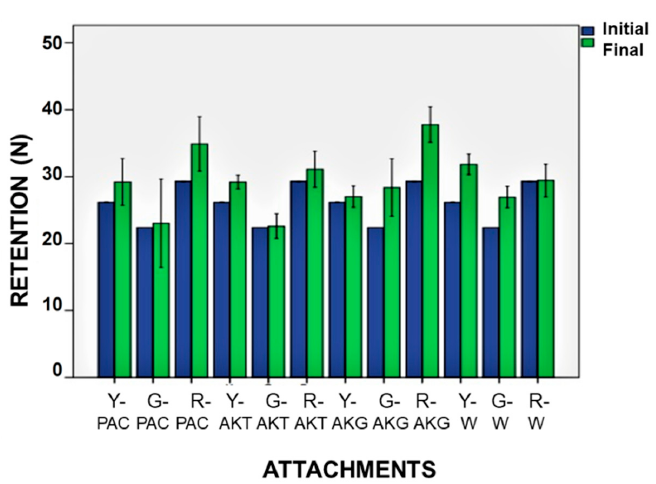
Figure 2. Retention values (N) before and after cleansing (Y: yellow, G: green, R: red, PAC: Protefix Active Cleanser, AKT: Aktident Cleansing Tablet, AKG: Aktident Cleansing Gel, W: water). The retention of yellow attachments increased after immersion in AKG, PAC, or water ( p = 0 .012) (Figure 3). The differences in retention of green attachments after im- mersion in different solutions were statistically significant ( p = 0 .028); the retention in- creased after immersion in AKG ( p = 0 .04) or water ( p = 0 .02) (Figure 4). The retention of red attachments increased after immersion in AKG or PAC ( p = 0 .045). Although the re- tention value of the red attachment increased after soaking in AKT, the change was not statistically significant ( p > 0 .05). Water had no effect on the retention of red attachments (Figure 5). Figure 3 . Percent change in retention values for yellow attachments after immersion in different cleansing solutions .